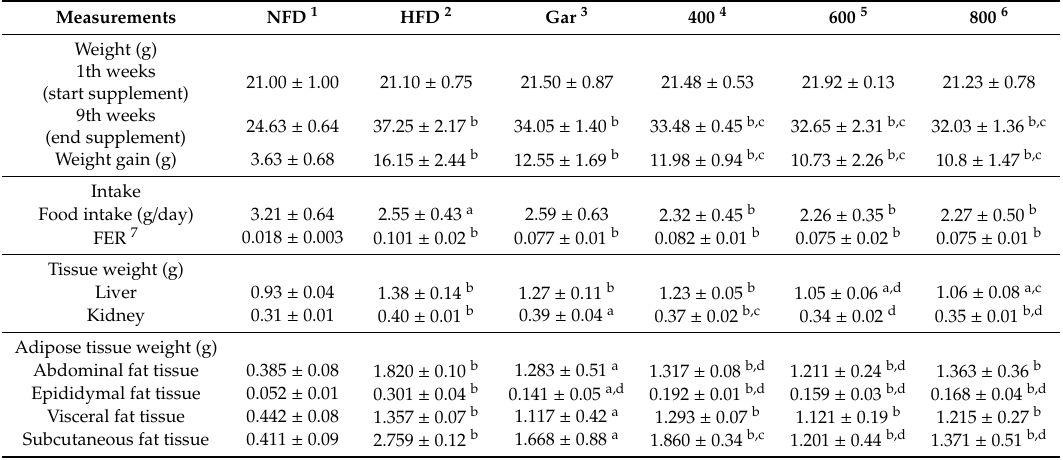
Table 3. Measurements of weight gain, food intake, the food e ffi ciency ratio (FER), and tissue